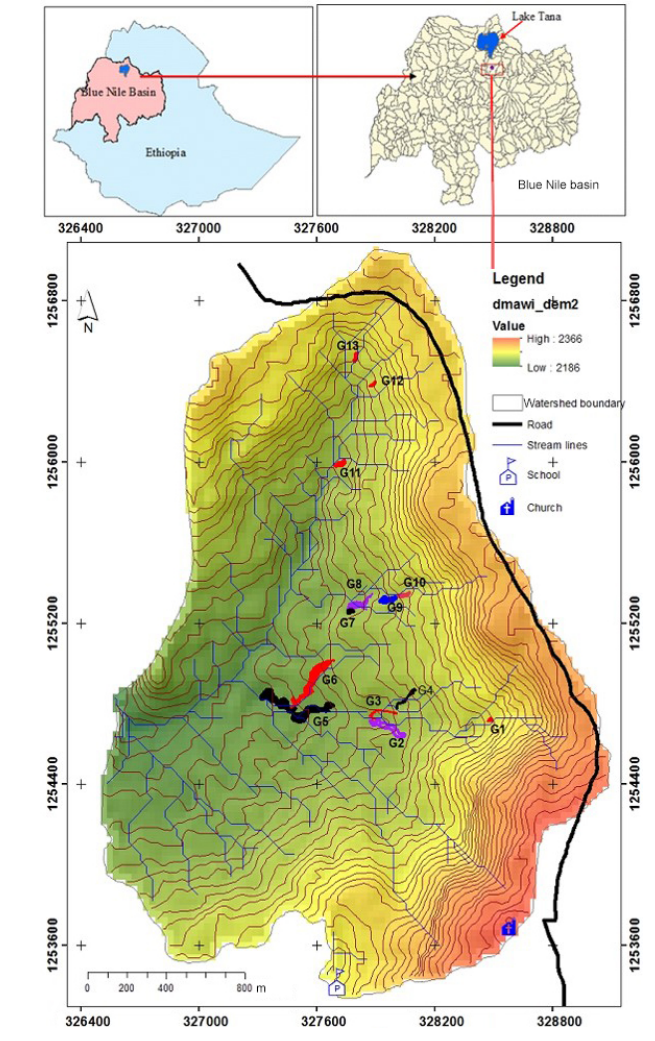
Figure 2. Location of the Debre Mawi watershed within the Blue Nile River basin, Ethiopia (top figures). The watershed map (bottom) shows the contour lines, elevation, streams lines, and the 13 studied gullies (shown in distinct colors and la- beled beginning with the letter G). Projected coordinate